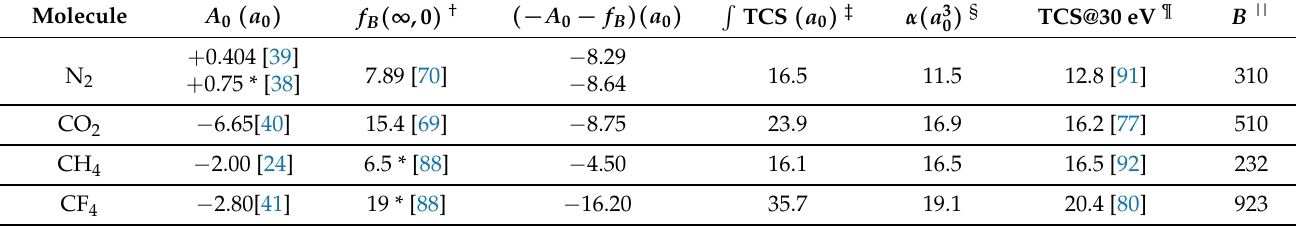
* data read from the figure. † The Born direct scattering amplitude f B ( E = ∞ , θ = 0 ) is taken as the square root of the differential cross sections at zero angle and at sufficiently high energies (see Figure 8). ‡ The integral over TCS in the dispersion relation, Equation (2), is taken within limits 10 − 6 eV to 10 6 eV (this range assures the independence of the result from the limits of the integration); the uncertainty of the integral is some 10%. § For dipole polarizabilities we give experimental values (see NIST database [93]). ¶ TCS in column 7 are in 10 − 16 cm 2 units. || B stays for the high-energy term in Bethe-Born TCS approximation, Equation (4) (in a 0 R units, R being the Rydberg constant); the uncertainty is about 10%, see Figures 6 and 7.